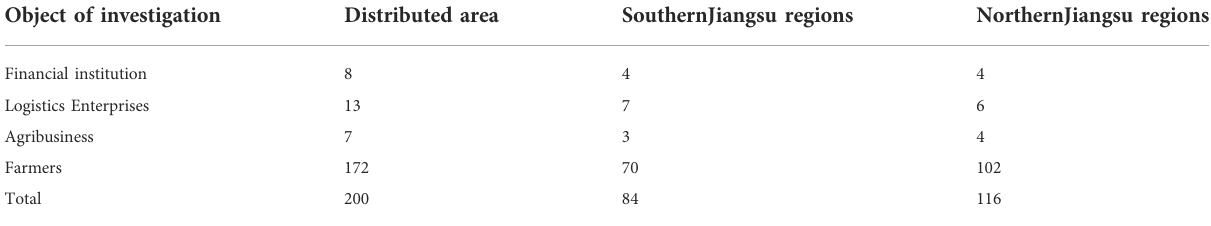
TABLE 2 Distribution of the number of survey objects (Source: collated by authors according to the research process).